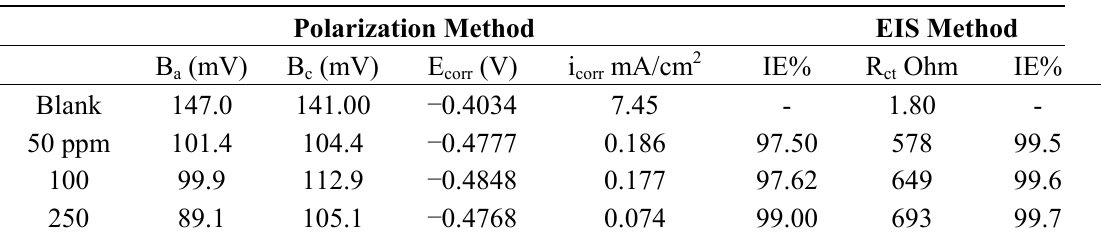
Table 2. Inhibition efficiency of PAMPS-Na-co-St/magnetite composite values for steel in 1 M HCl with different concentrations of inhibitor calculated by the polarization and EIS methods.